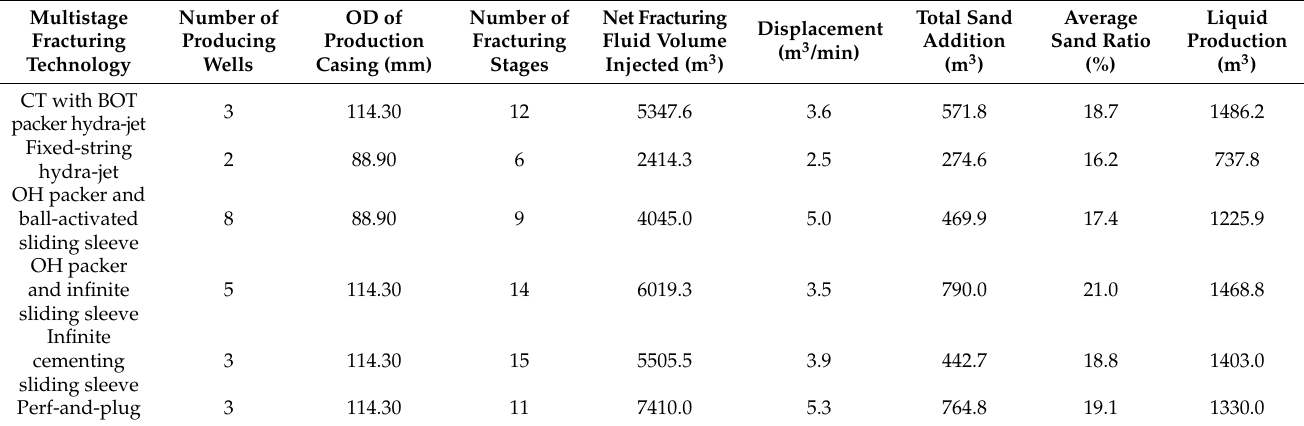
Table 4. Parameters of horizontal well multistage fracturing